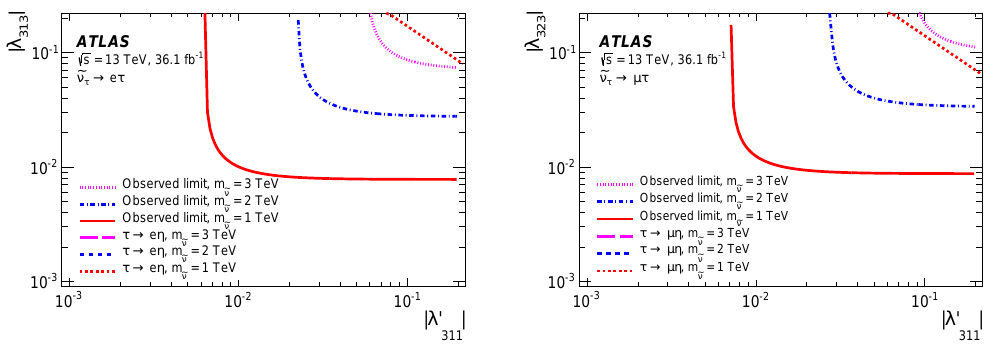
Figure 8: The observed upper limits on the lepton flavour violating e τ and µτ cou- | (a coupling between first genera- plings as a function of another RPV coupling | λ (cid:48) 311 tion quarks and the tau-sneutrino) for a tau-sneutrino decay [ 20 ] . The observed limit for 13 TeV collisions now exceeds that of measurement of LFV via direct τ decay. input variables.